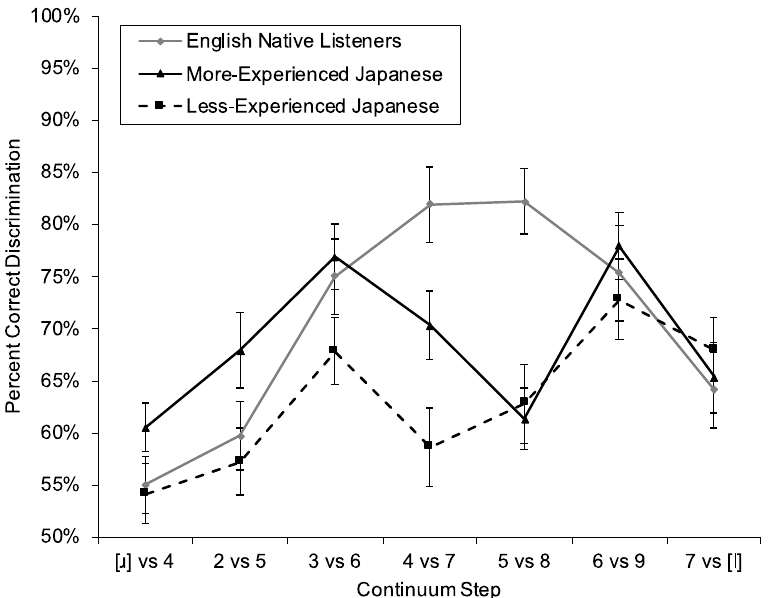
Figure 3. Mean percent correct discrimination of pairs of steps from the /r/–/l/ continuum for the three participant groups. Error bars represent standard errors of the mean.